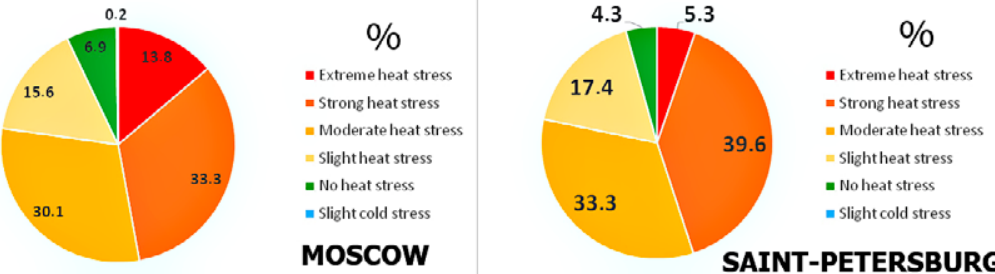
Figure 2. Frequency of РЕТ grades in Moscow and Saint-Petersburg in the day time during heat waves (1966 - 2015